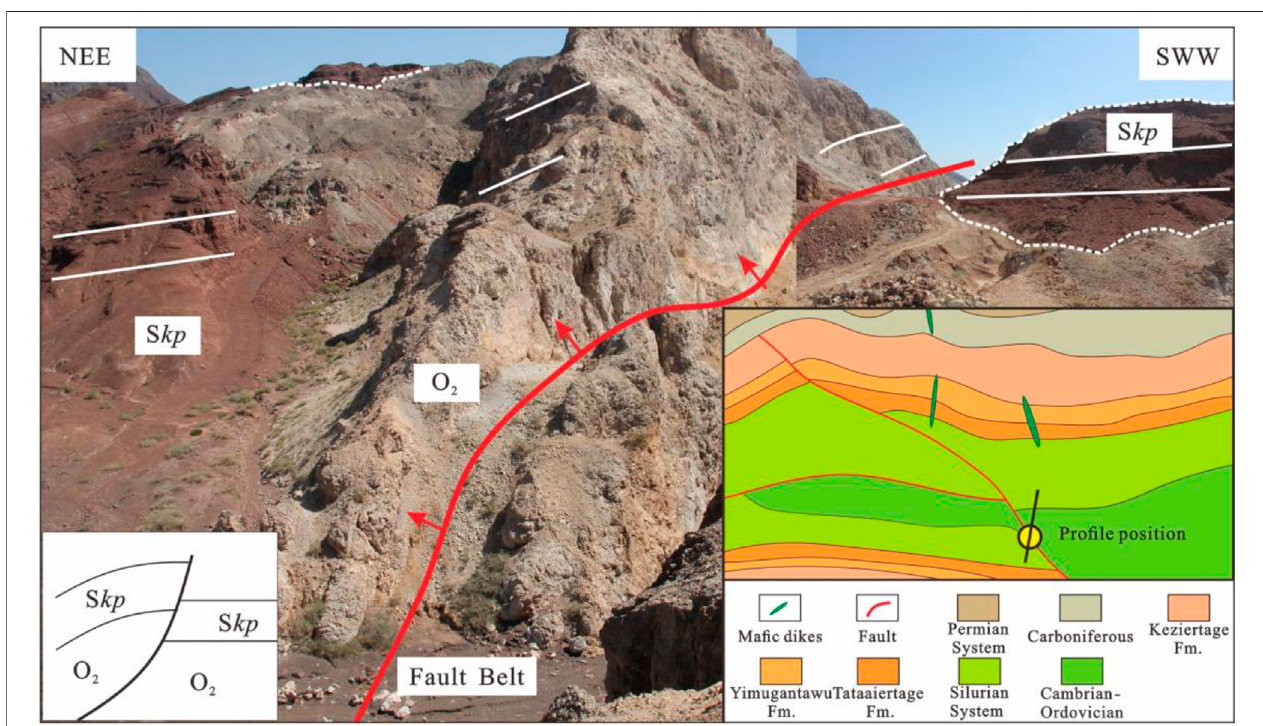
FIGURE2| TheXike ’ erfaultpatternandmacroscopiccharacteristics.Thelocationofthesectionisshowninthegeologicalmapontheplaneplan.Inthepro fi lethe red line is the fault plane and the arrow points to the hanging wall of the reverse fault.